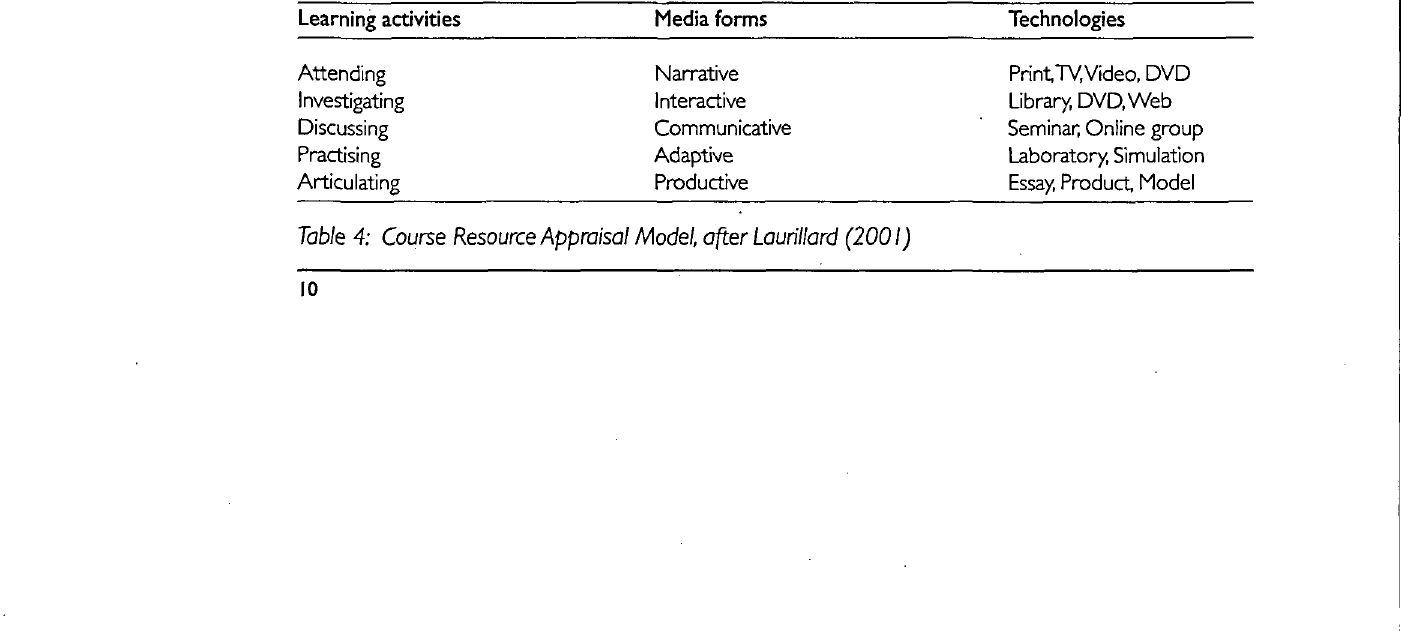
Table 4: Course Resource Appraisal Model, after Laurillard